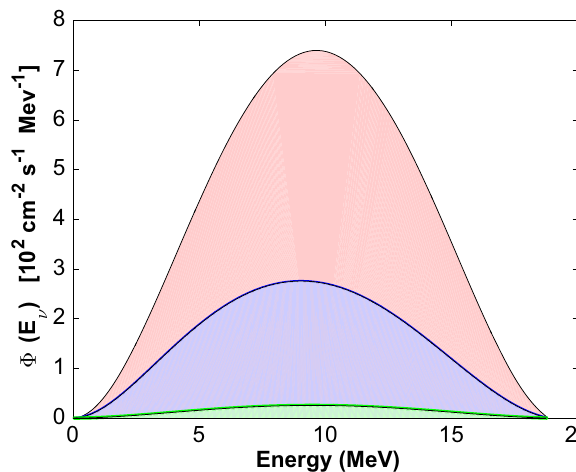
Fig. 6 Neutrino spectrum of hep nuclear reaction. The colour scheme is the same used in Fig. 5